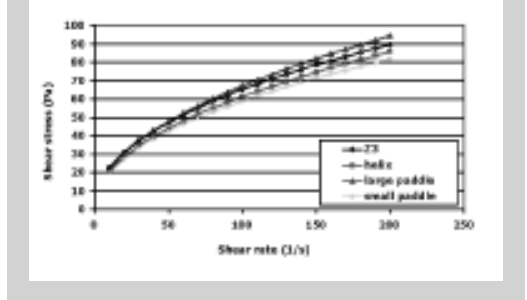
Figure 3 (left): Shear stress versus shear rate obtained with conven- tional system (Z3) and three evaluated mixer systems for béarnaise sauce. Figure 4a (right above): Shear stress versus shear rate obtained with three evaluated mixer systems for raspberry fruit preparation (linear axes). Figure 4b (right below): Shear stress versus shear rate obtained with three evaluated mixer systems for raspberry fruit preparation (logarithmic axes).